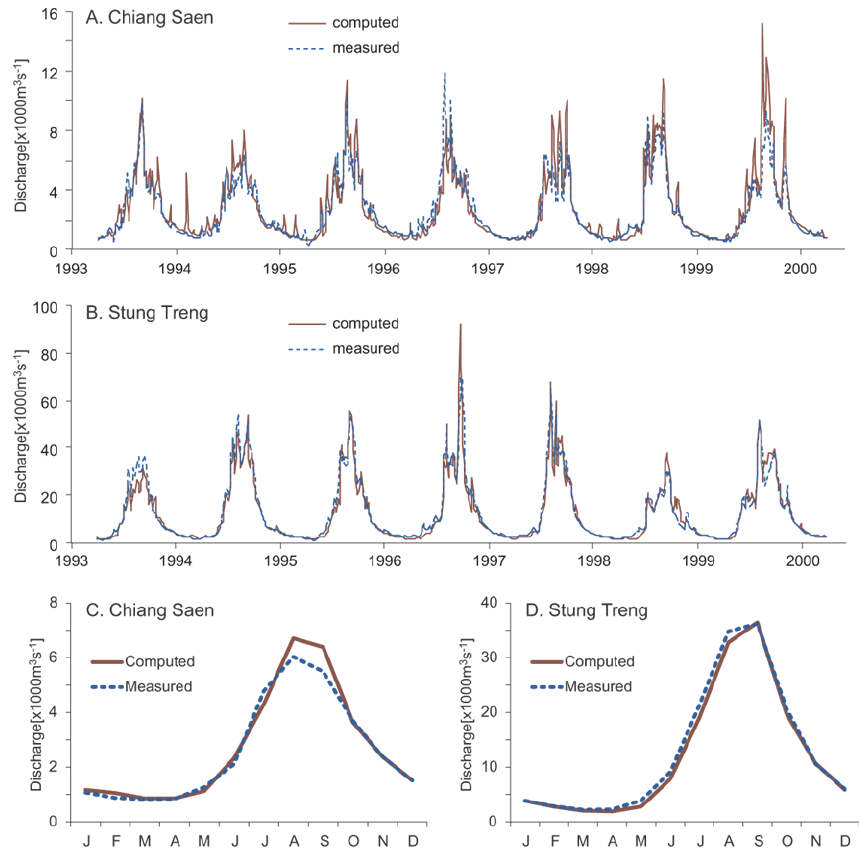
Fig. 2. Validation results of the VMod hydrological model. (A) Daily discharge at Chiang Saen; (B) daily discharge at Stung Treng; (C) monthly average discharge at Chiang Saen; and (D) monthly average discharge at Stung Treng. The validation period is 1993–1999. See Table 3 for efficiency coefficient results and Fig. 1c for the location of the measurement